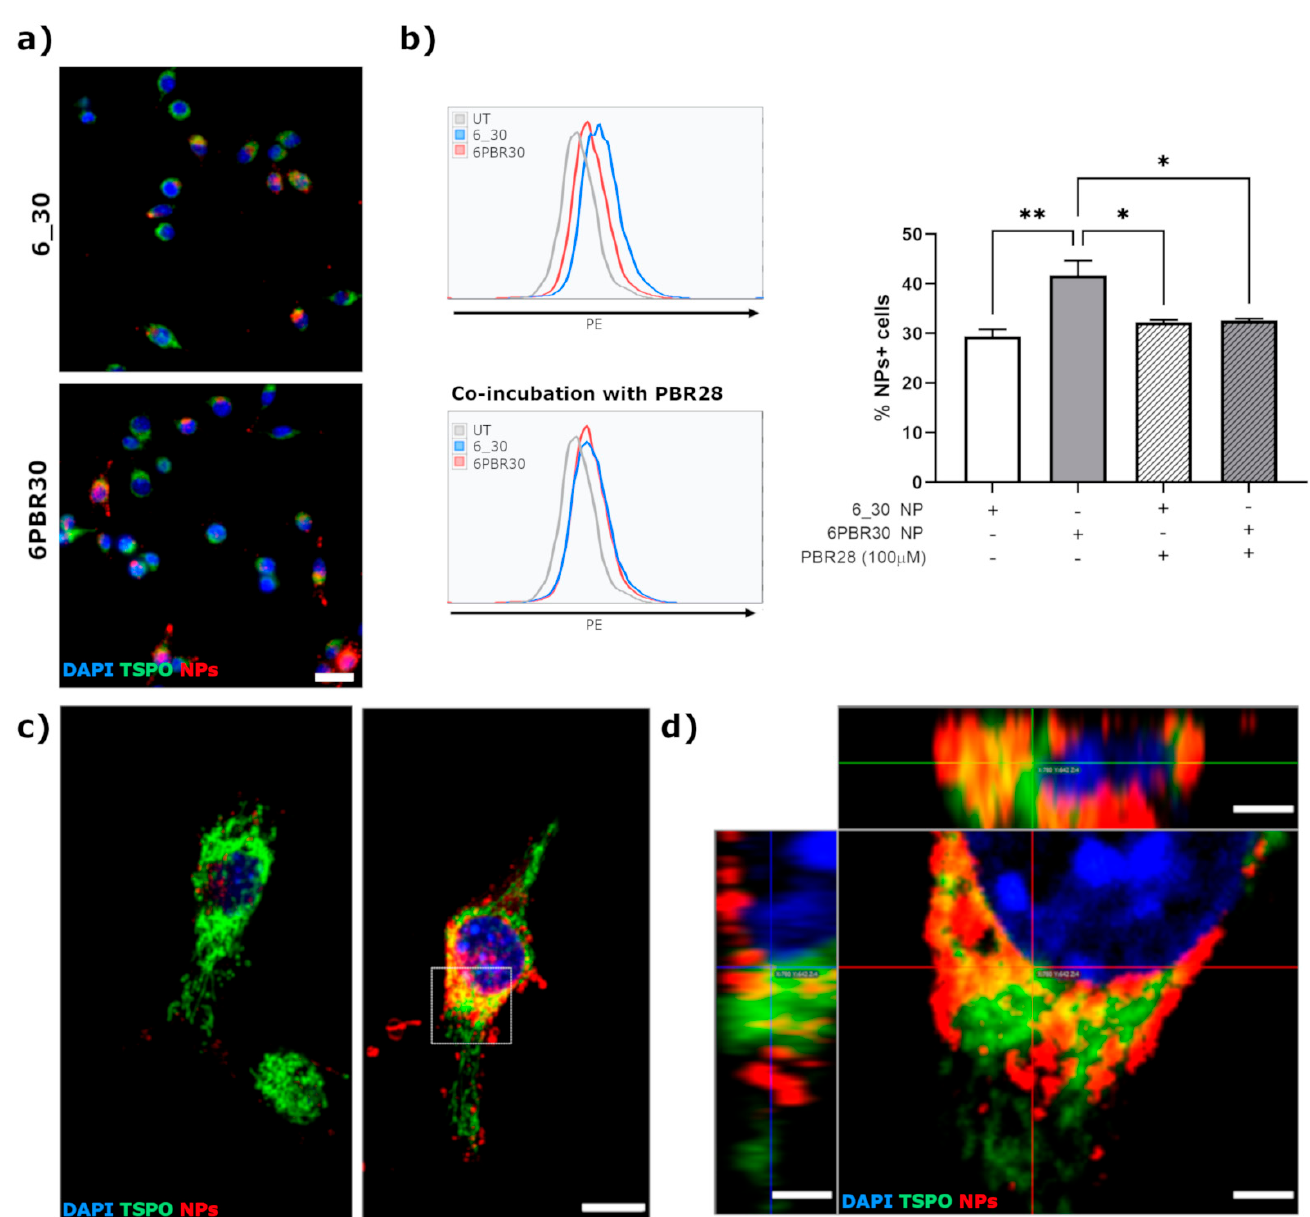
Figure 6 . ( a ) Internalization of DiI-labeled 6_30 and 6PBR30 NPs in BV2 TSPO-GFP clone #4 cells, evaluated by epifluorescence microscopy at 4 h after NPs administration; scale bar = 25 μ m; ( b ) Representative flow-cytometric plots and corresponding quantification of the percentage of DiI+ cells (measured in the phycoerythrin channel–PE) at 4 h after administration of DiI-labeled 6_30 or 6PBR30 NPs, in absence or presence of the free unconjugated PBR28 TSPO ligand. * = p < 0.05; ** = p < 0.01; ANOVA followed by Tukey’s post-hoc test; ( c ) representative laser scanning confocal microphotographs showing the extent of co-localization between NPs (red signal) and TSPO-GFP (green signal) at 4 h after NP administration, scale bar = 10 μ m; ( d ) high magnification orthogonal projection of the region highlighted by the dashed-box in figure ( d ), scale bar = 2.5 μ m.